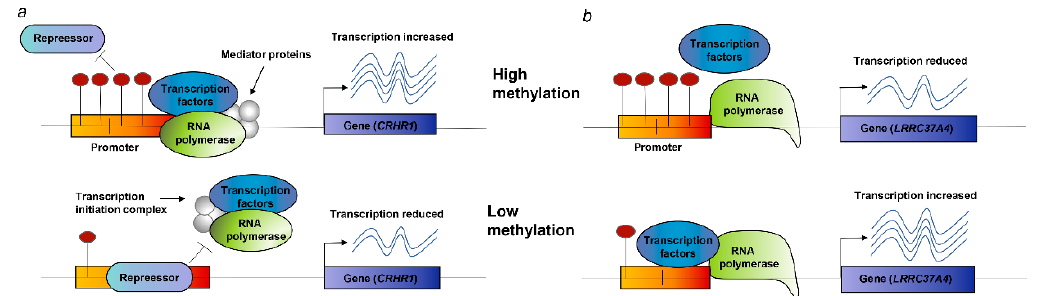
Figure 7. Potential regulatory mechanisms. ( a ) When the DNAm site in the promoter is high, the binding of the inhibitor and the promoter is prevented; the transcription factor normally binds to the promoter, and the expression of CRHR1 increases; when the DNAm site is low, the inhibitor binds to the promoter, and CRHR1 transcription is suppressed. ( b ) When DNAm in the promoter is high, the binding of transcription factors is disrupted, thereby suppressing the expression of LRRC37A4 . When DNAm is low, transcription factors usually bind to the promoter, and the expression level of LRRC37A4 increases.